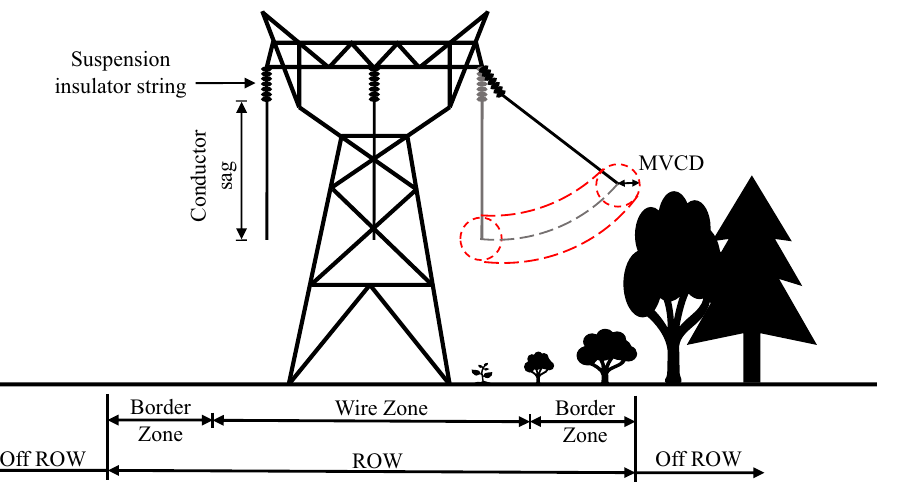
Figure 3. Transmission line